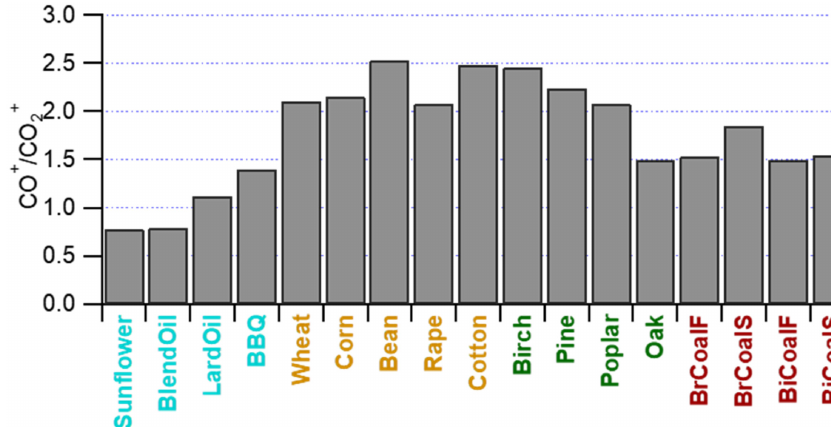
Figure 2. The ratio of measured CO + / CO + spectively) ratios (2.0–2.7) and low O / C ratios